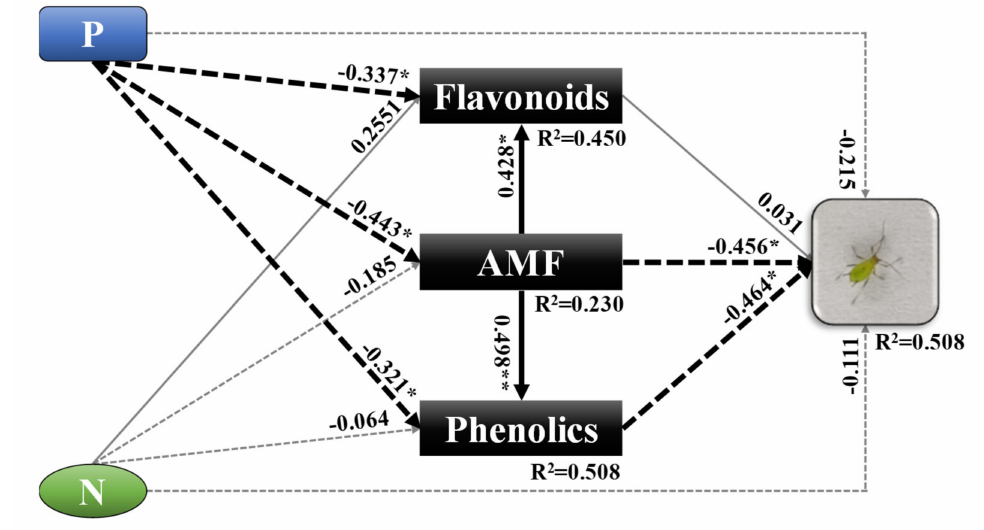
Figure 5. Structural equation modeling (SEM) indicated the direct and indirect e ff ects of the amounts of nitrogen and phosphorus fertilization on AMF, aphids, flavonoids, and phenolics in wheat leaves. Numbers adjacent to arrows are the pathway coe ffi cients and the e ff ect size of the relationship. Continuous arrows mean positive relationships, dashed arrows mean negative relationships, thin and gray lines mean no significant relationship at the 5% level ( p > 0.05), and thick and black lines mean a significant relationship at the 5% level ( p < 0.05). Significance is indicated by * p < 0.05, ** p < 0.01. The model created was satisfactorily fitted to our data based on the following values: χ 2 = 0.849; GFI = 1.000; RMSEA = 0.000; p = 0.357. In the pathway, N is nitrogen, P is phosphorus, AMF represents arbuscular mycorrhizal fungi, aphid represents the number of S. avenae , and flavonoids and phenolics represent the respective concentrations (mg / g) of total flavonoids and total phenolics in dry